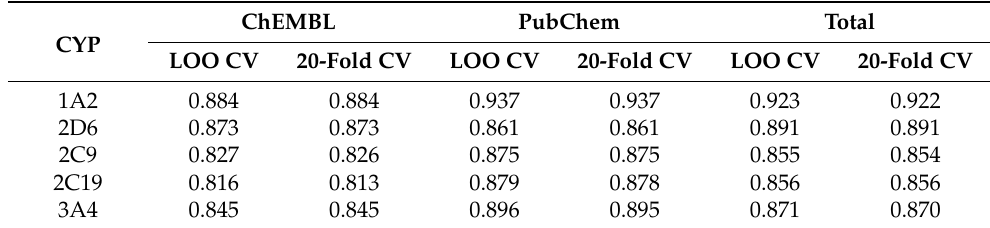
Table 2. Prediction accuracy (IAP) for classification